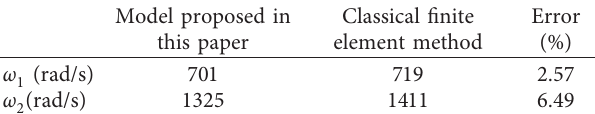
Table 1: The comparison of the critical speeds. Model proposed in